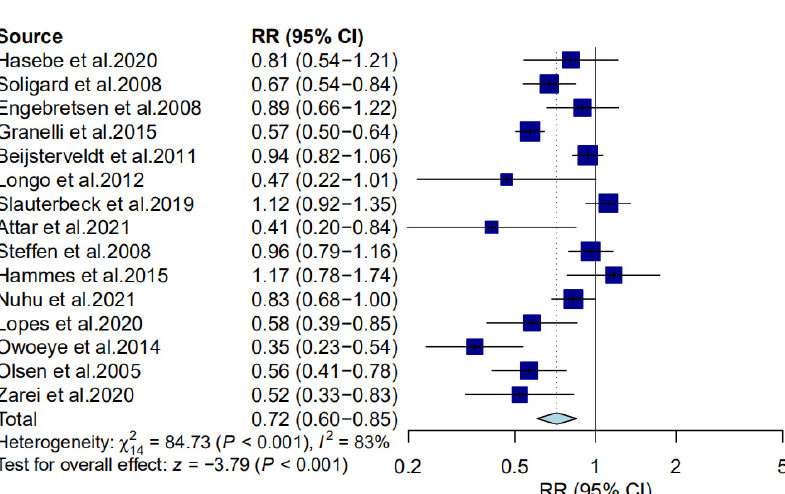
Figure 4. Primary analysis of overall lower extremity injury rates in hamstring eccentric exercise prevention programs compared with control intervention